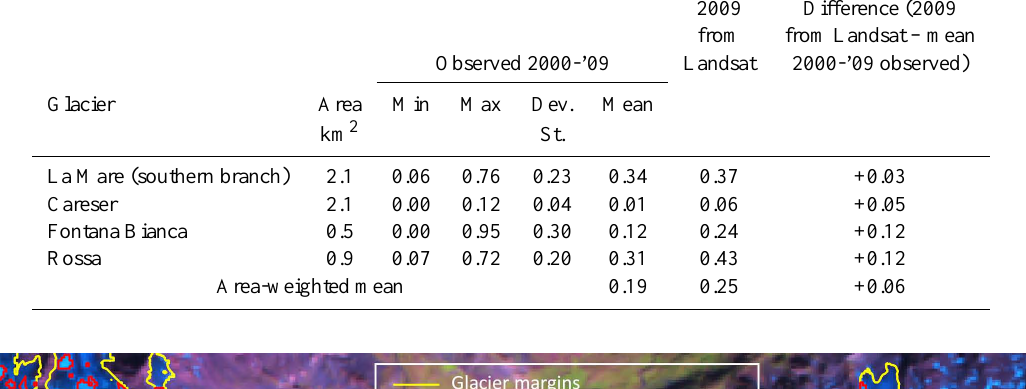
Table 2. Comparison of the mean values of the accumulation area ratio obtained from direct observations (decade 2000–2009, this work) with the value obtained from the Landsat scene of 31 August 2009, for four glaciers of the Ortles-Cevedale group. The location of the glaciers is reported in Fig. 1.